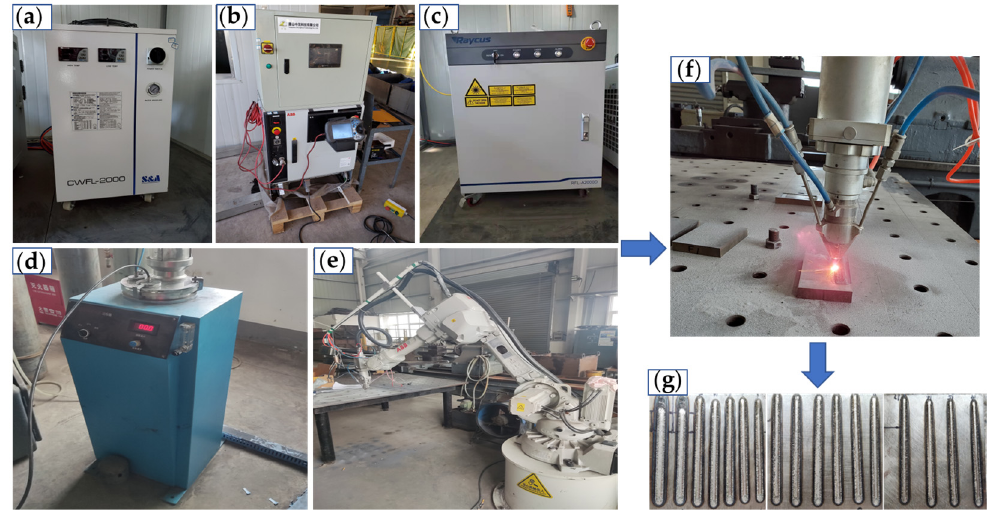
Figure 2. Experimental setup. ( a ) Cooling system; ( b ) control cabinet; ( c ) laser generator; ( d ) synchronous powder feeder; ( e ) ABB five axis manipulator; ( f ) cladding process; ( g ) laser cladding specimens.